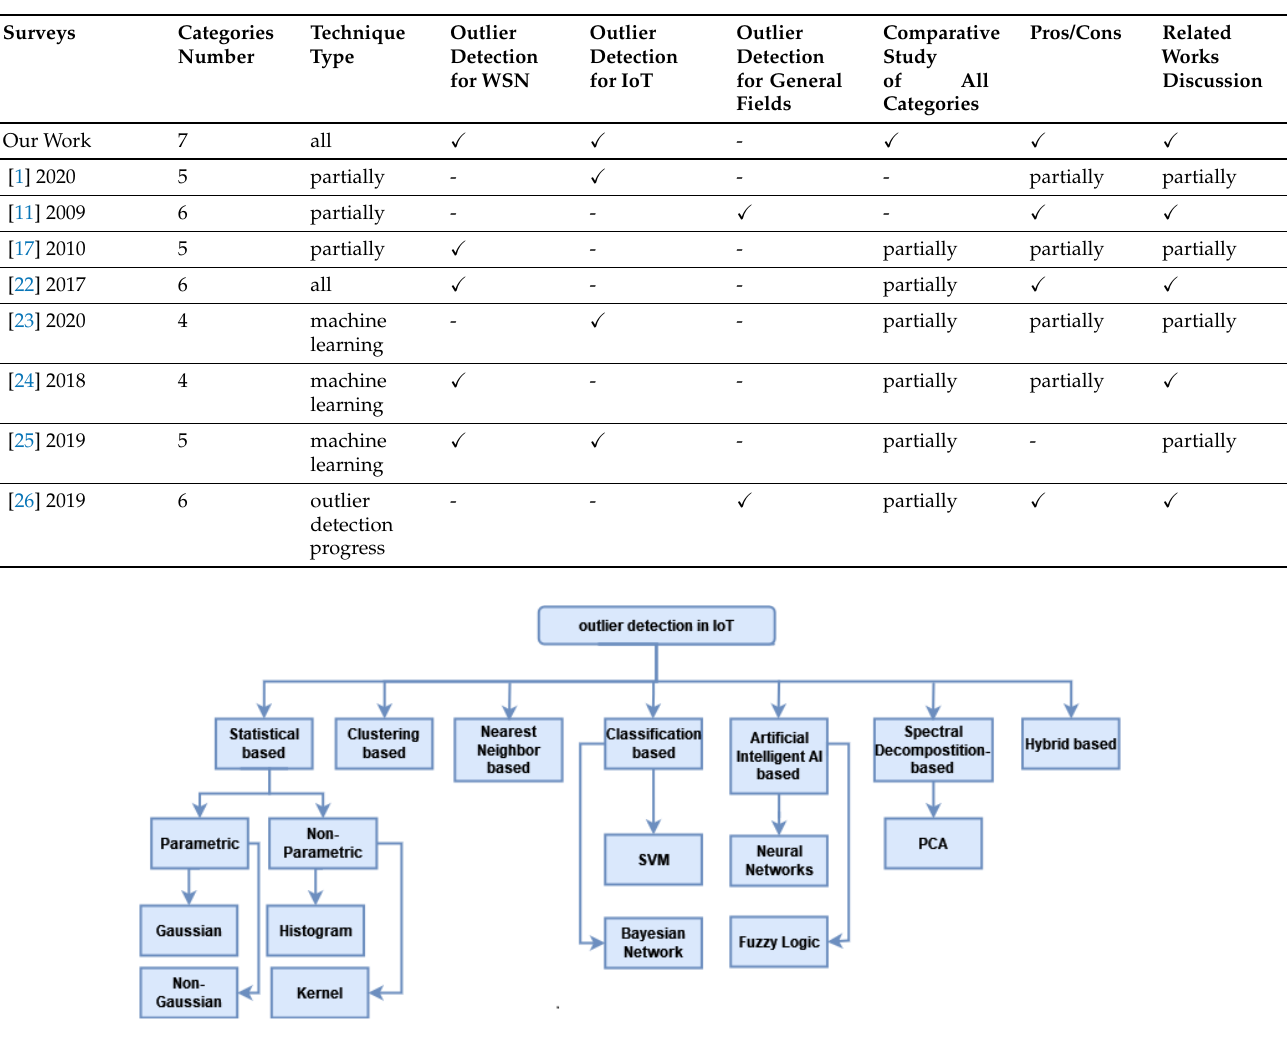
Table 1. Comparative table of our survey versus already existing ones.